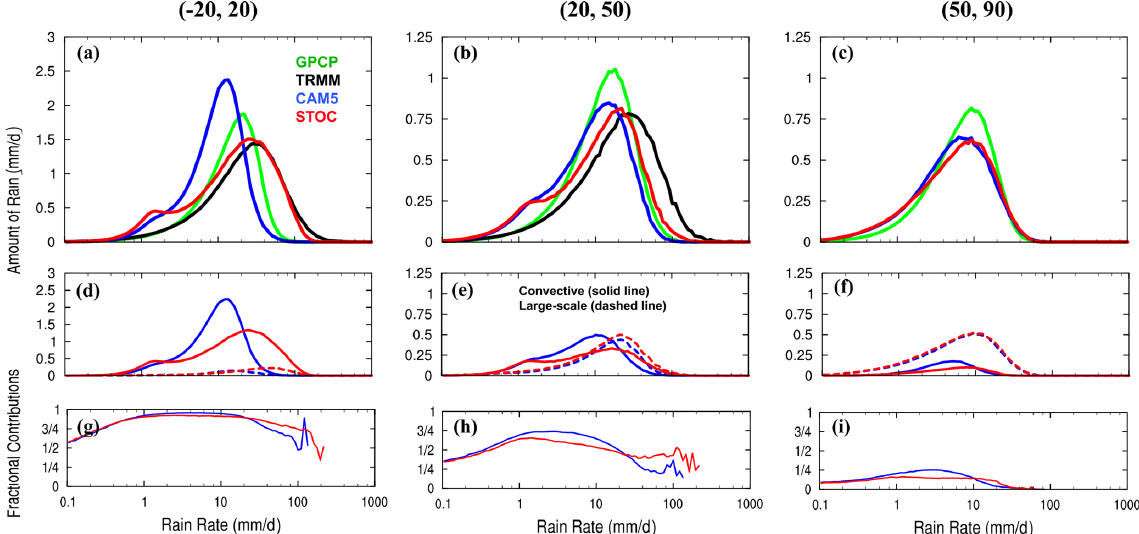
Figure 2. Amount distributions of (a–c) total, (d–f) convective and large-scale precipitation and (g–i) fractional contributions of convective precipitation to total precipitation over (a, d, g) 20 ◦ S, 20 ◦ N, (b, e, h) 20, 50 ◦ N and (c, f, i) 50, 90 ◦ N. Total rainfall amounts are shown for CAM5 (blue), STOC (red), GPCP (green) and TRMM (black) while convective (solid line) and large-scale (dashed line) rainfall amounts and the fractional contributions of convective precipitation are shown for CAM5 and STOC. The amount distributions (units: mmd − 1 ) are scaled by (cid:49) ln (R) = (cid:49)R/R , which has units of mmd − 1 /mmd − 1 and is a unitless scaling term.